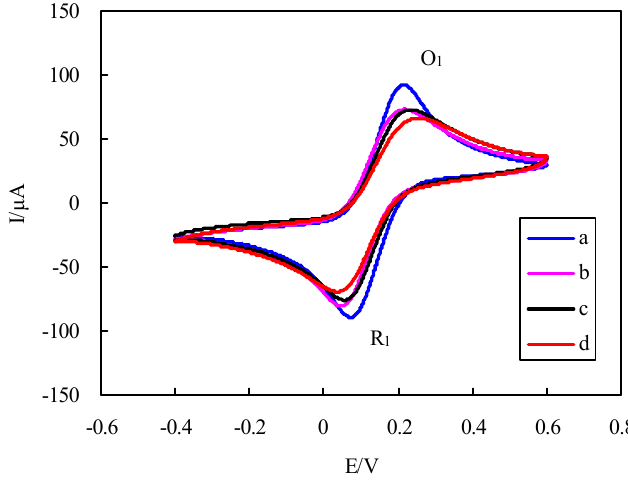
Figure 4. Cyclic voltammograms of the GNP-SPCEs obtained under the following conditions: ( a ) at the bare GNP-modified SPCE; ( b ) after antibody immobilization; ( c ) after BSA blocking; and ( d ) after cell binding (4 × 10 5 CFU/mL) in the solution of 2.5 mM K [Fe(CN) ] + 2.5mM K [Fe(CN) ] + 0.1 M KCl + 10 mM PBS (pH = 7.4). Scan 4 6 3 6 . The oxidation peak: O rate, 100 mV/s. The reduction peak: R 1 1